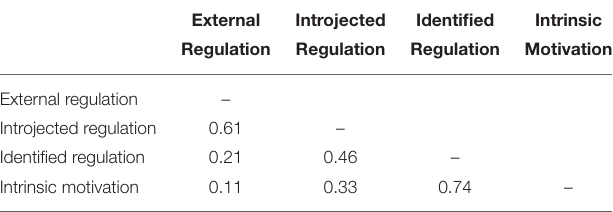
TABLE 3 | Pearson correlation coefficients among the four scales of the German version of the 28-item SRQ-A. External